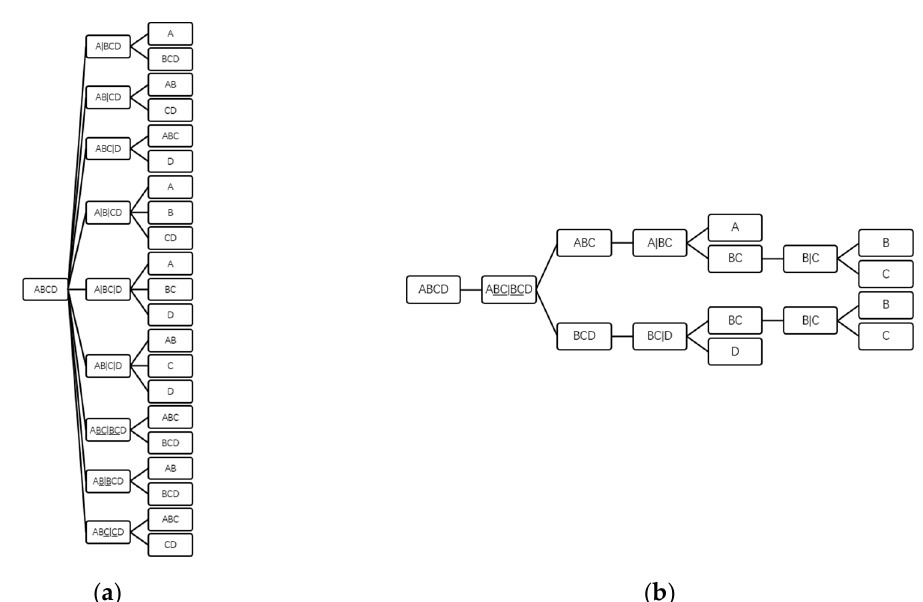
Figure 2. Two kinds of hybrid multiway tree structures for different representation functions are listed as: ( a ) A four-component non-sharp solution space with only three levels expanded and ( b ) a four-component non-sharp distillation sequence (the letters represent the components and the underlined ones represent the middle components).